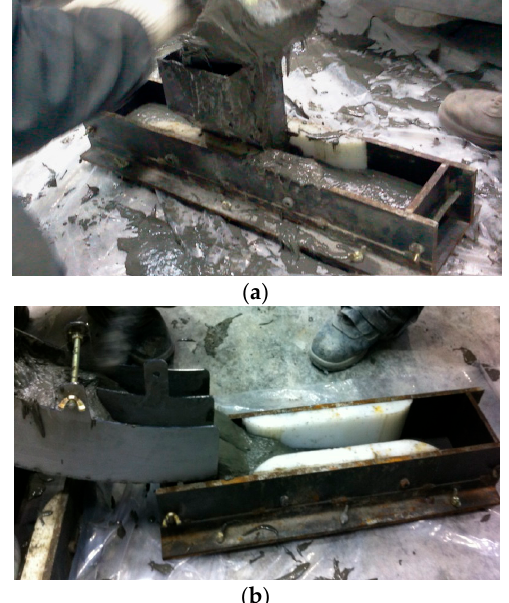
Figure 1. Two different casting methods: ( a ) Casting to induce a random fiber distribution in the middle of the specimen; ( b ) casting to induce fiber alignment along the flow direction.